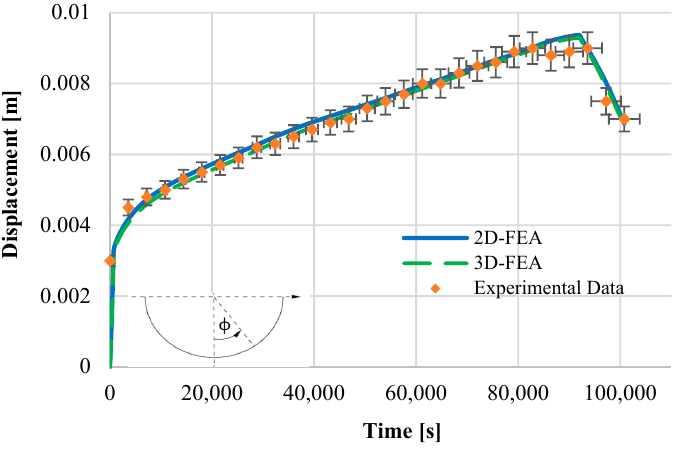
Figure 11. Experimental vs. numerical displacements at ϕ 0 °.